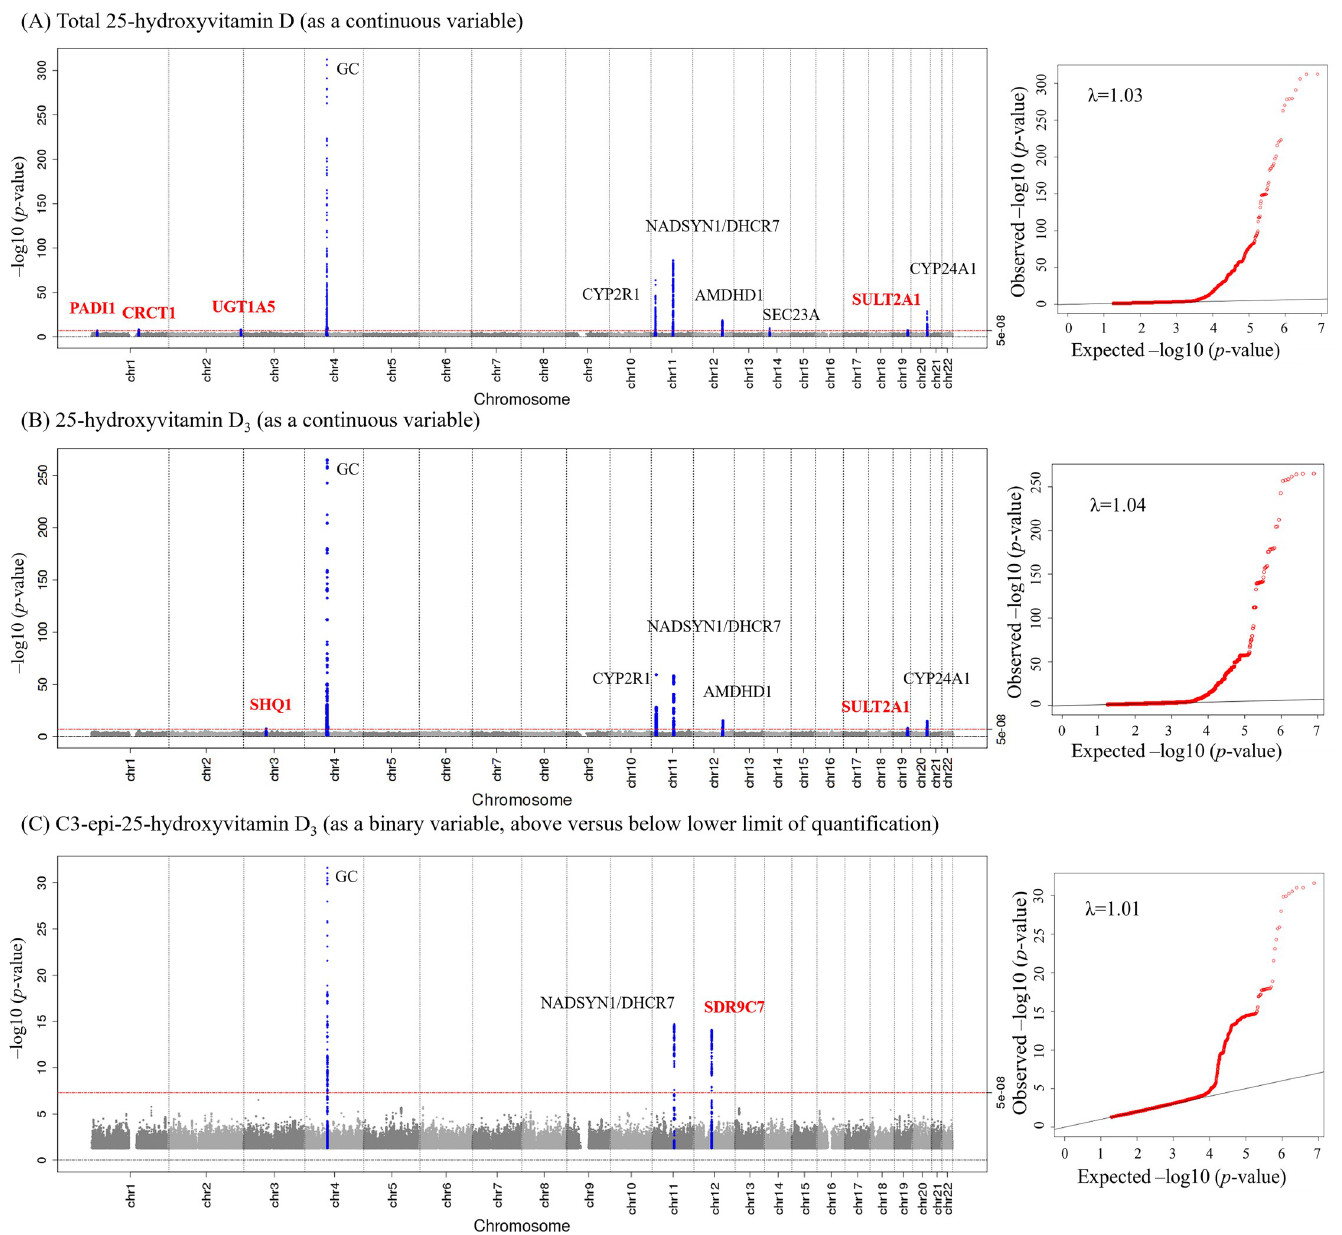
Fig 2. Genome-wide association of circulating 25-hydroxyvitamin D metabolites: Manhattan plot and quantile–quantile plot of all genetic variants from the meta-analysis. Manhattan plot and quantile–quantile plot for each of total 25-hydroxyvitamin D (A), 25-hydroxyvitamin D 3 (B), and C3-epi-25-hydroxyvitamin D 3 (C). Manhattan plot (left): SNPs are plotted on the x -axis according to their positions on each chromosome. The red line indicates the threshold for genome-wide significance ( p < 5 × 10 − 8 ). Blue points represent SNPs in the ± 100-kb region of a top hit. Loci are annotated with the gene names closest to the SNPs with lowest p - values (red indicates novel loci identified in the present study). Quantile–quantile plot (right): The x -axis shows the expected − log 10 p- values, and the y -axis shows the observed − log 10 p- values. Each SNP is plotted as a red dot, and the black line indicates the null hypothesis of no true